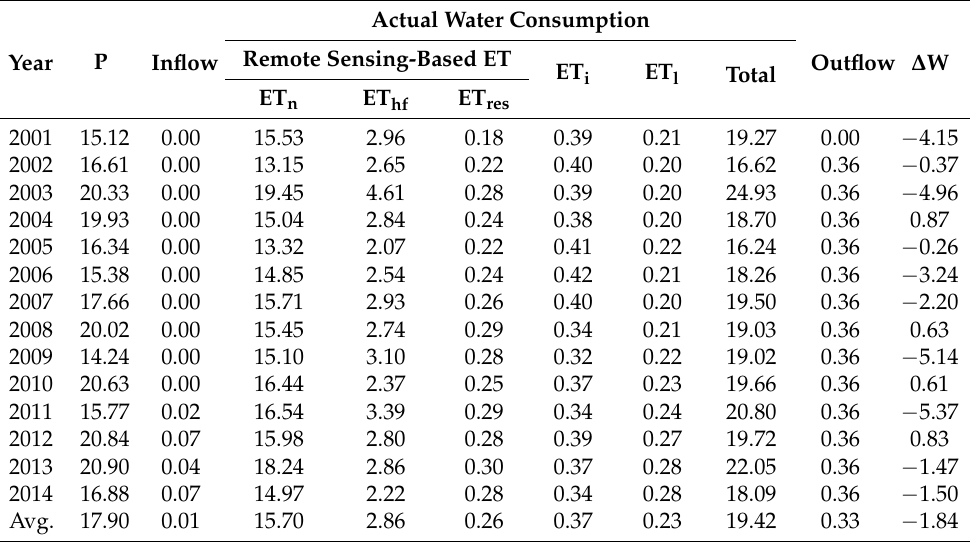
Table 1. Water consumption balance in the YD River Basin from 2001 to 2014 (10 9 m 3